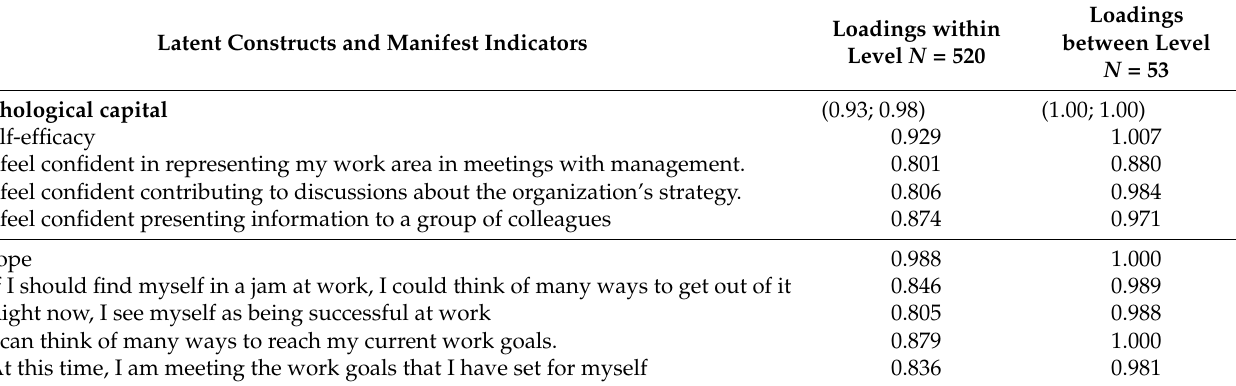
Table 3. Standardized factor loading scores for multilevel confirmatory factor